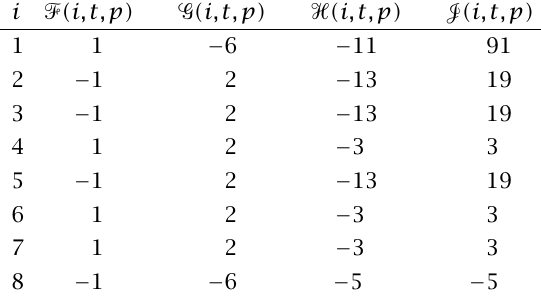
(cid:10) φ( − 1 ),φ(t),φ( 1 − t)